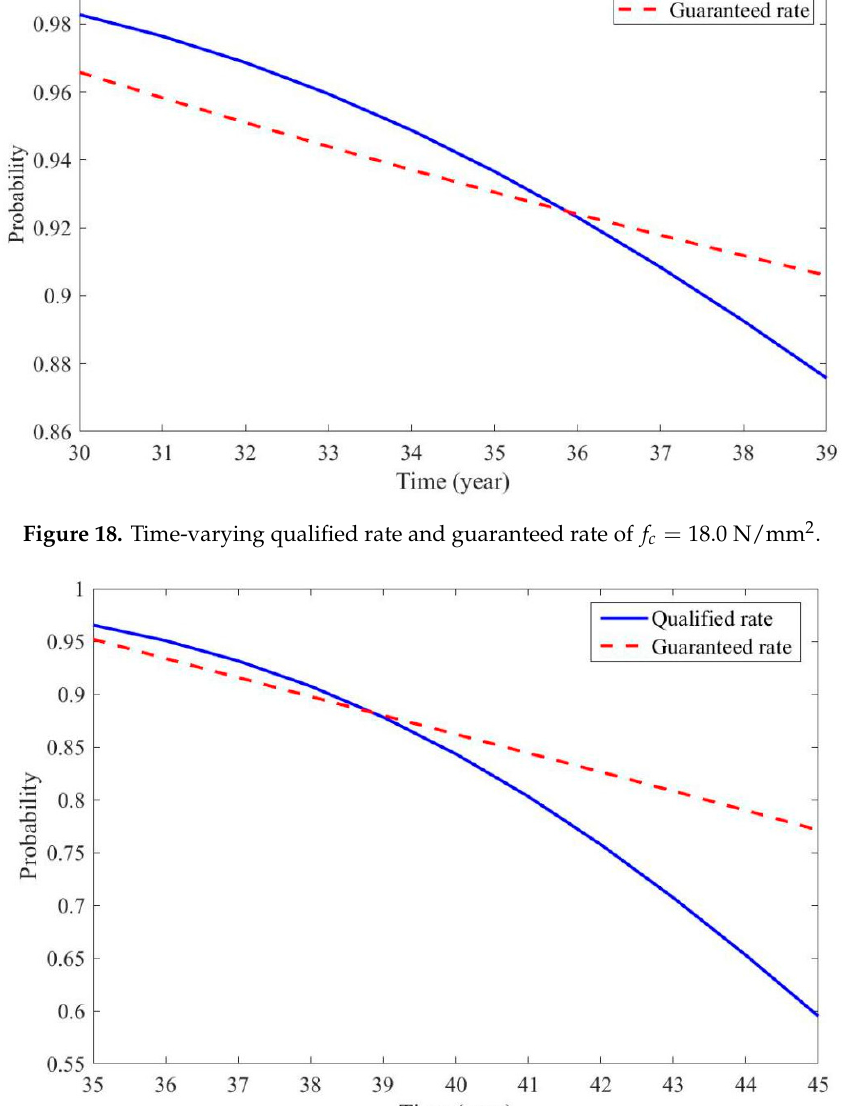
Figure 19. Time-varying qualified rate and guaranteed rate of 2 N/mm 21.0=